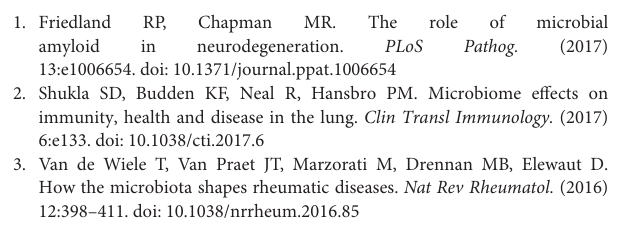
miRNAs develop dysbiosis and fecal miRNAs transplantation can